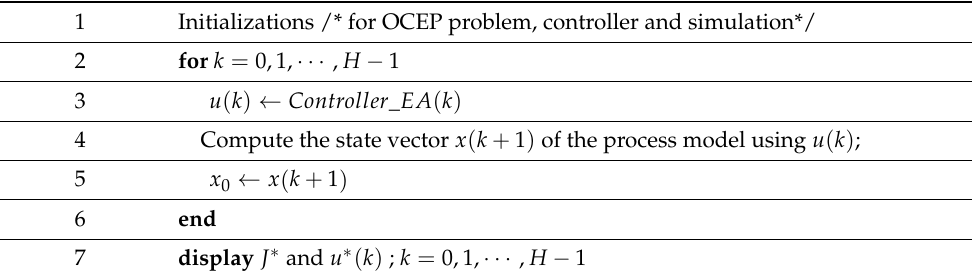
Table 5. Outline of the closed-loop optimal control using EAv1.